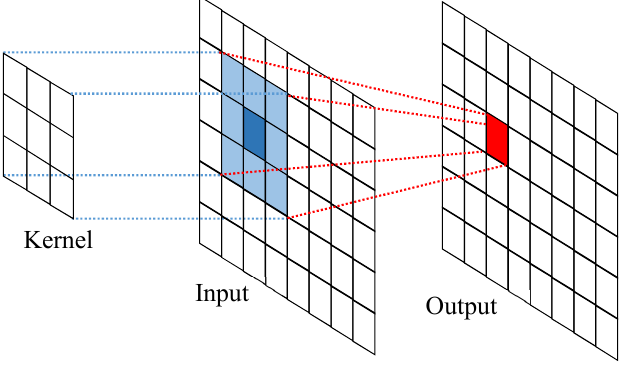
Figure 2. Kernel feature extraction, calculating the box-wise multiplication with the image box and convolution